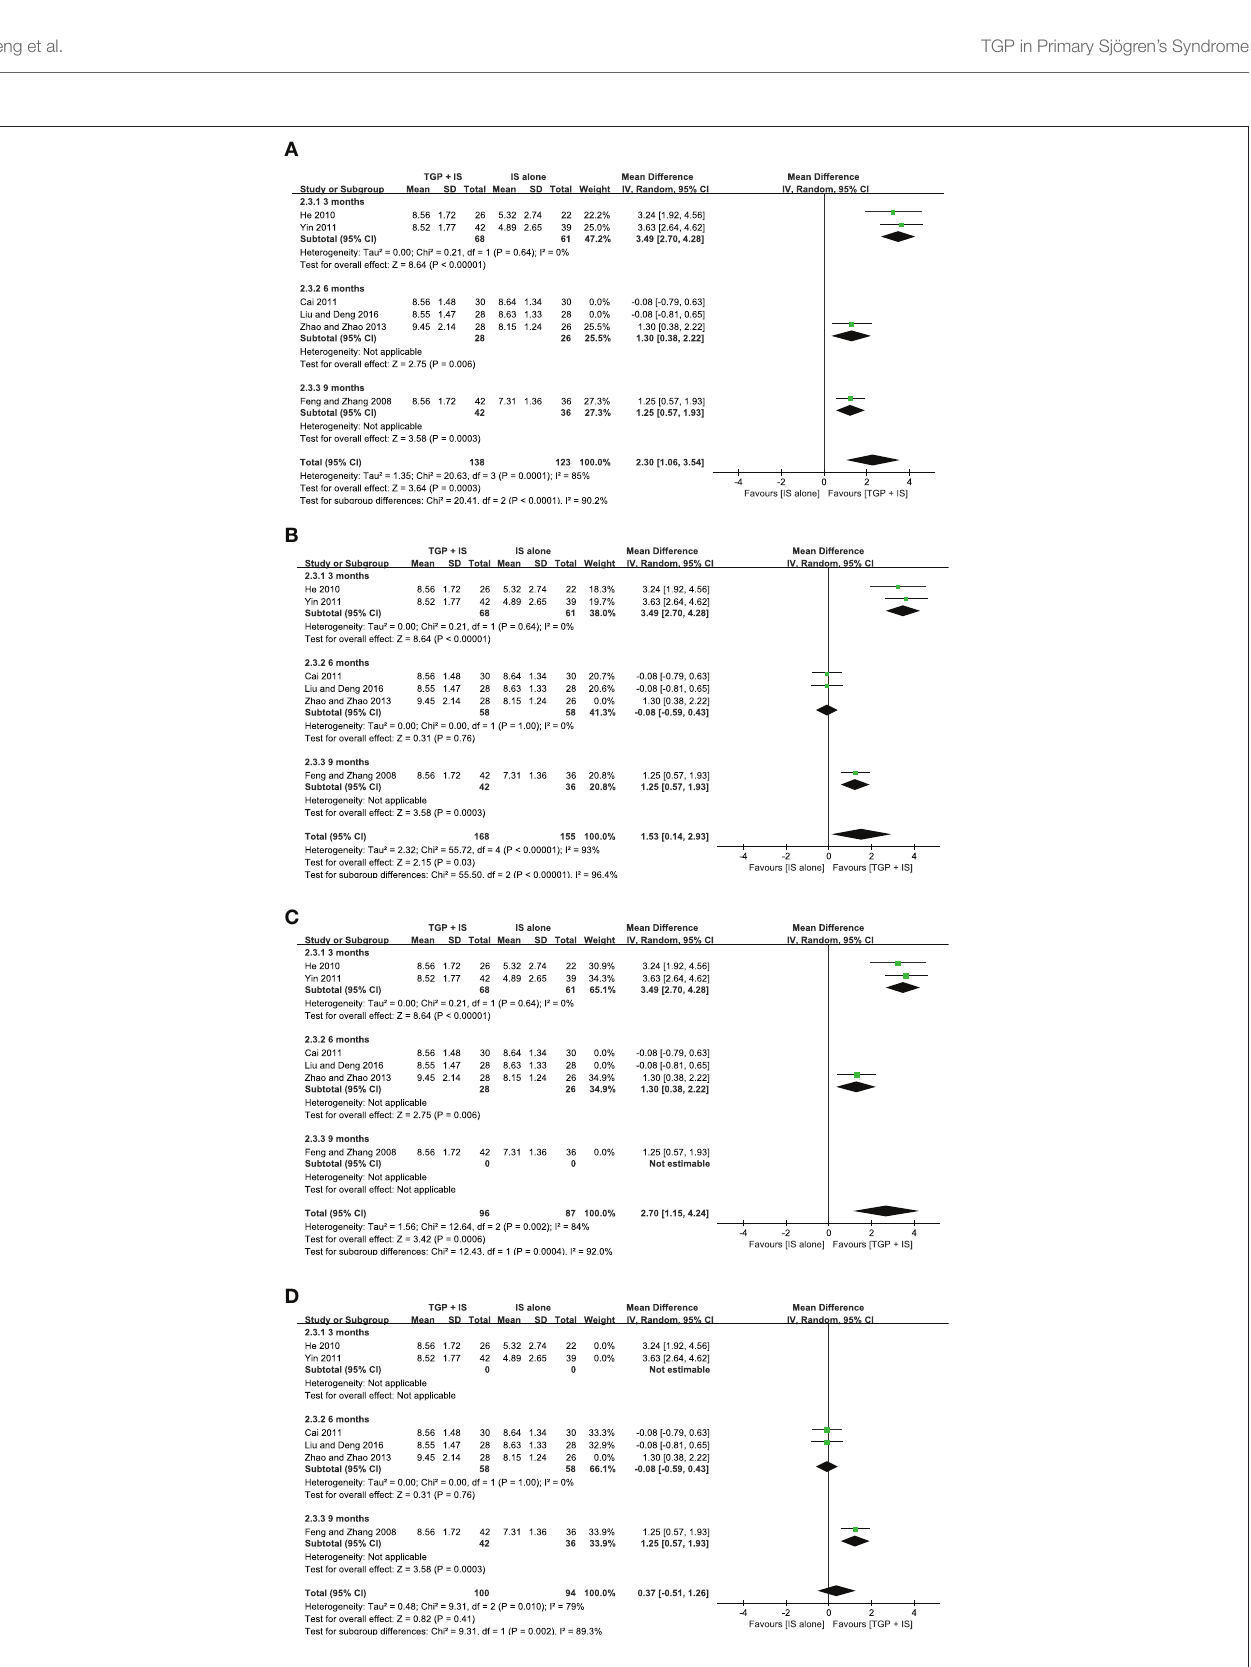
Frontiers in Pharmacology |